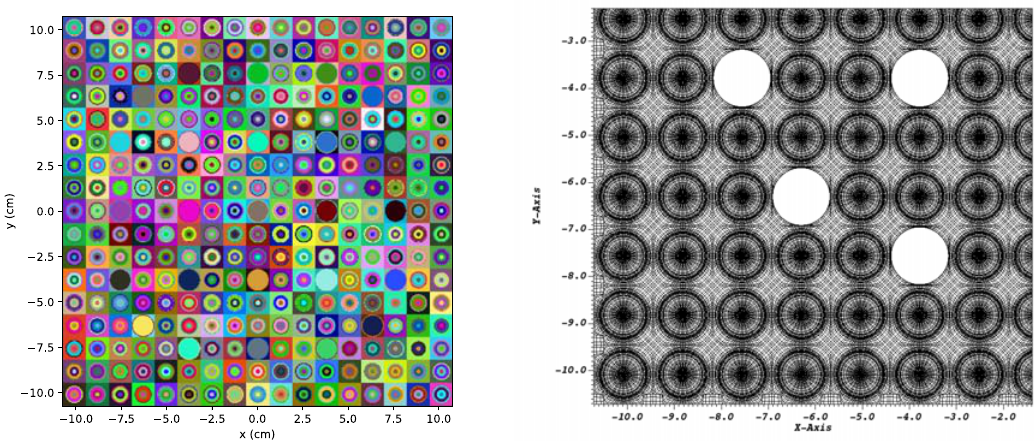
Figure 2: OpenMC and Nek5000